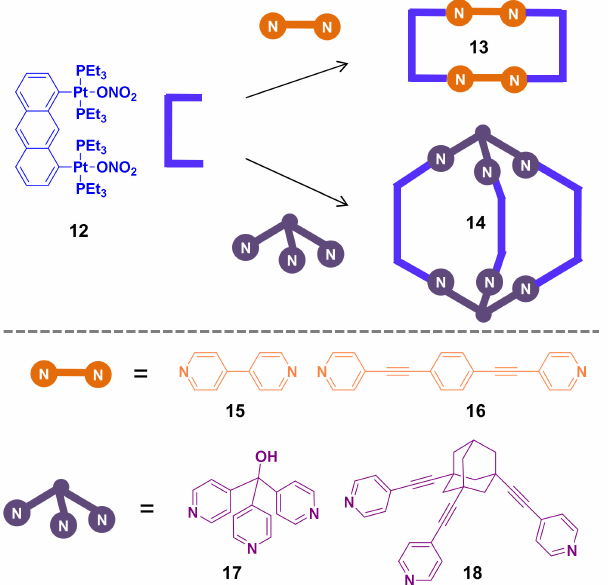
Figure 3. Diplatinum(II)-based anthracene-containing linker 12 for constructing nitrogen-based 2D and 3D coordination